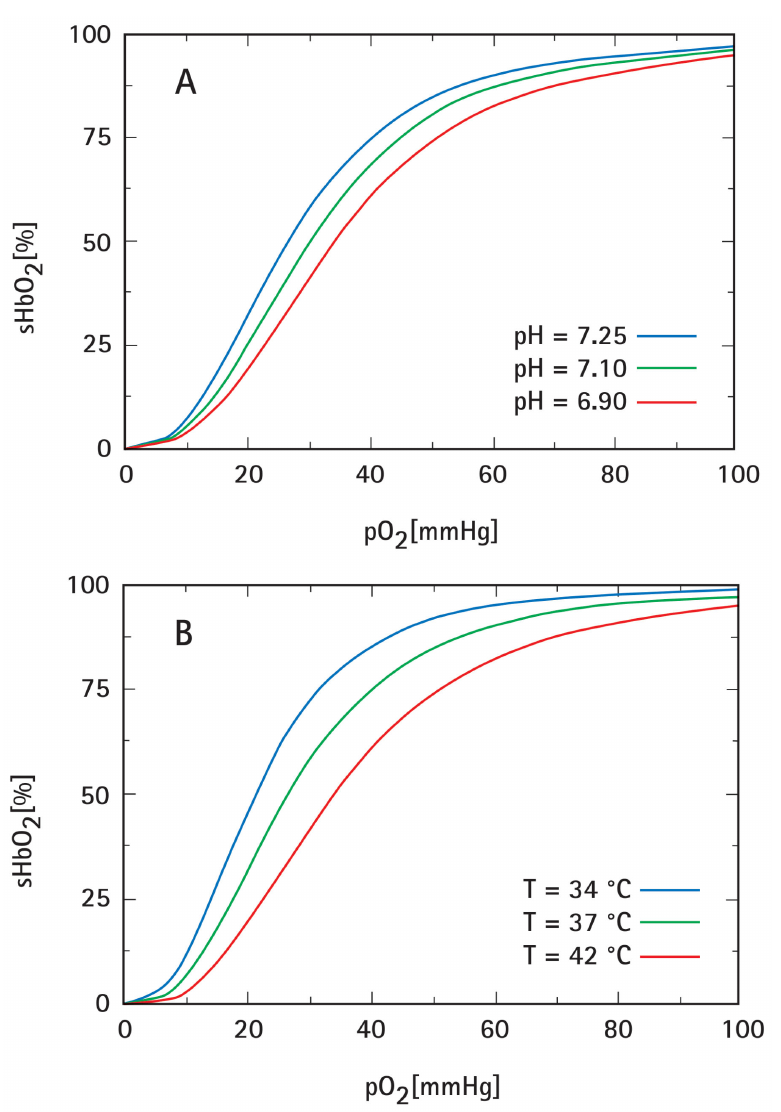
Figure 6. Right-shift of the HbO 2 -dissociation curve resulting from intensified tumor acidosis ( A ) and hyperthermic tumor tissue temperatures ( B ), both facilitating the O 2 release from oxyhemoglobin (HbO 2 ), i.e., enhancing O 2 unloading from red blood cells into the surrounding tissue. During mHT, a significant rise (+30%) of the CO 2 partial pressures in the